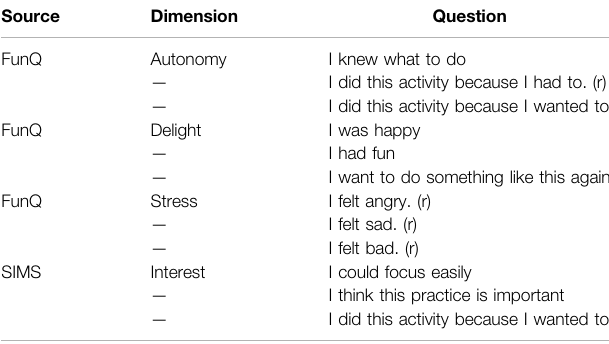
TABLE 2 | Motivation questionnaire questions.